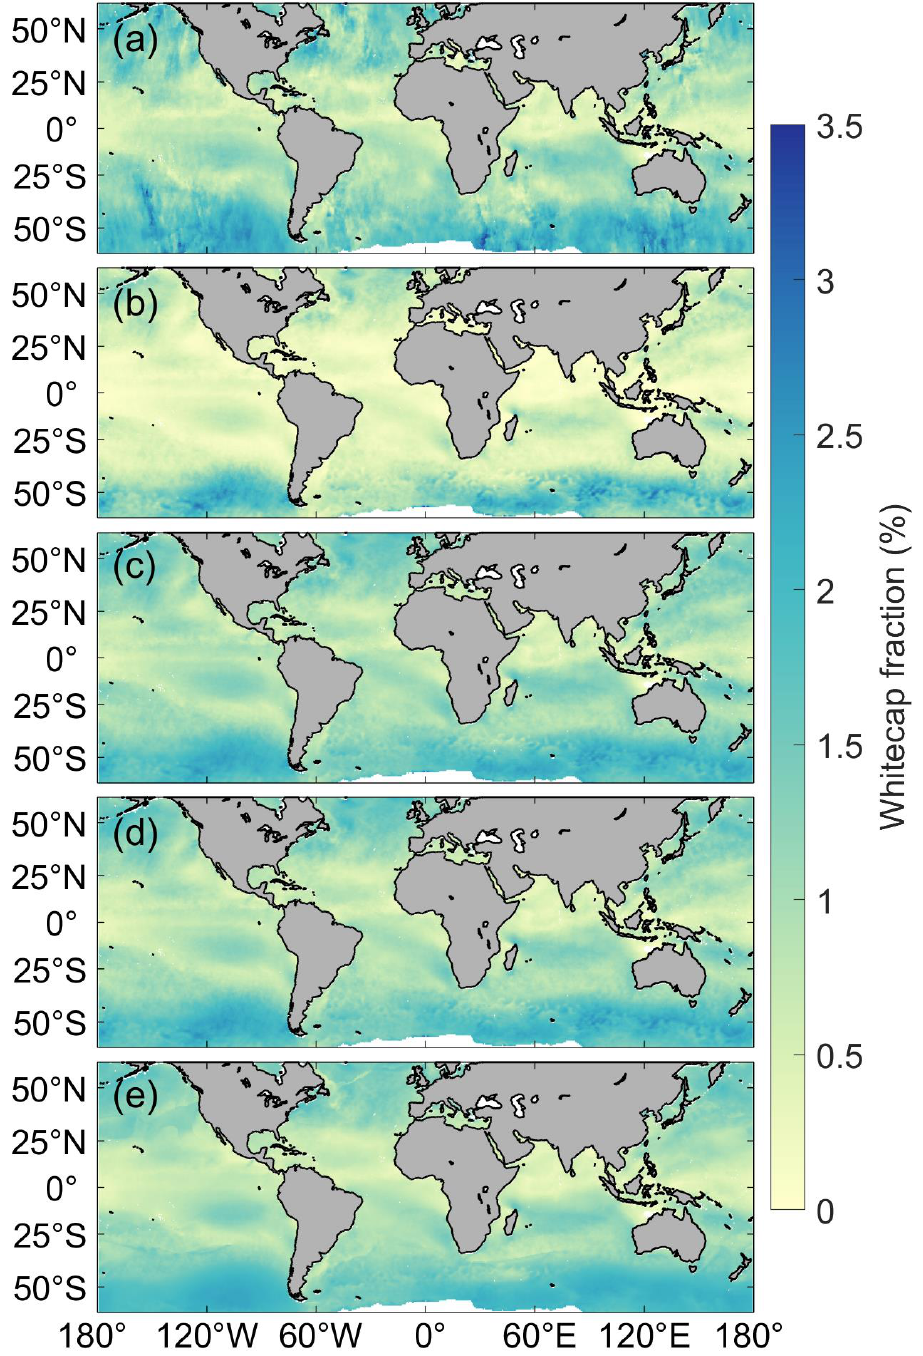
Figure 4. Monthly average whitecap fraction in October 2006; ( a ) satellite-derived; ( b ) M80; ( c ) S13; ( d ) A16; ( e ) NN-W.